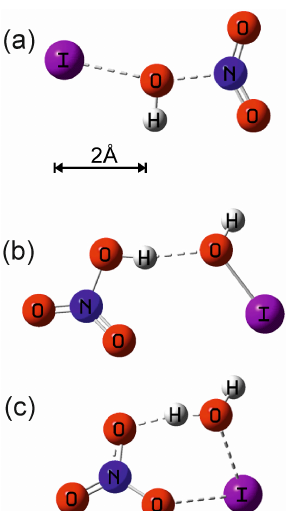
Figure 2. (a) Transition state for the reaction between HOI and NO 2 to form HNO 3 + I and (b) complex formed between HOI and HNO 3 , which then reacts via transition state (c) to form IONO 2 + H 2